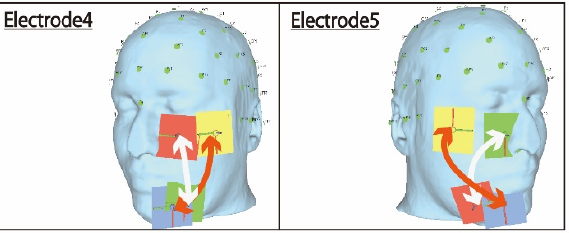
Figure 9. Comparison of the stimulus pathway between electrodes 4 and 5.